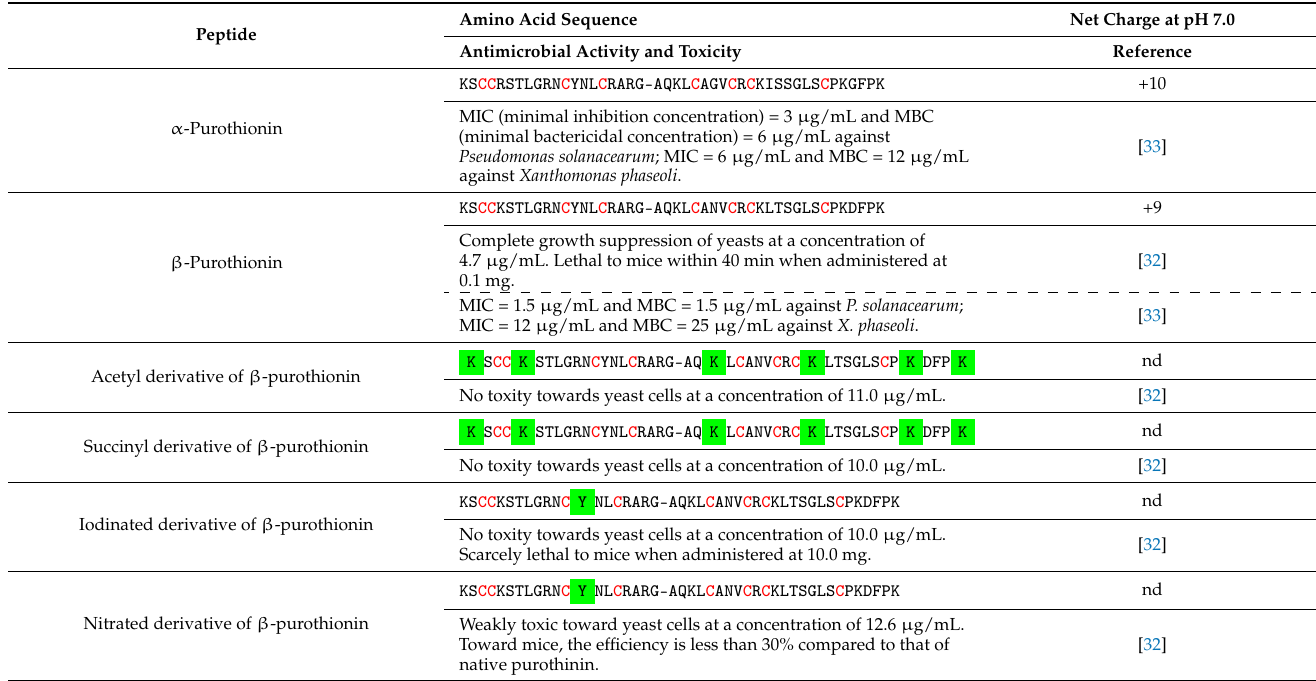
Table 1. Thionins and derived peptides: sequence, net charge at pH 7.0, and biological activity. Cysteine residues are shown in red, substituted amino acids are highlighted in cyan, and modified amino acids are highlighted in green. B— α -aminobutyric acid, c—D-cysteine, and X—homocysteine. Gaps ( − ) were introduced to improve the alignment. Note: nd—not determined. Net Charge at pH